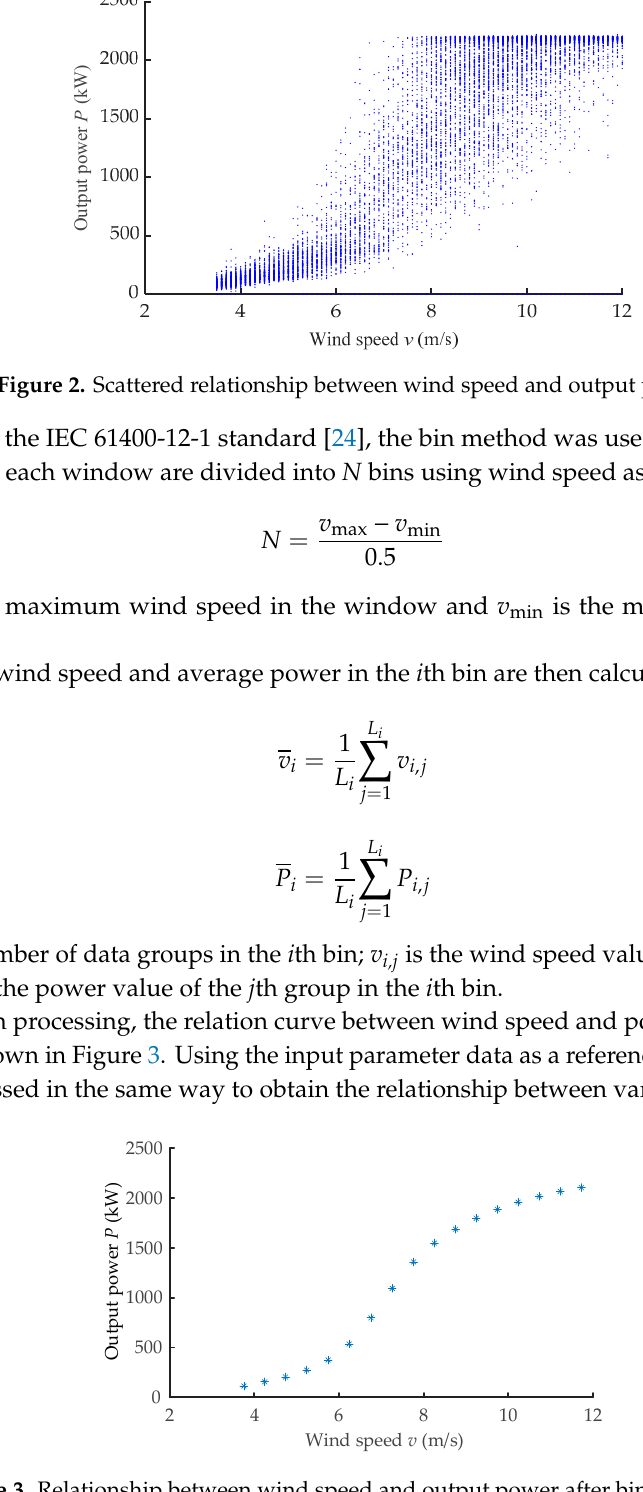
Figure 3. Relationship between wind speed and output power after bin processing.